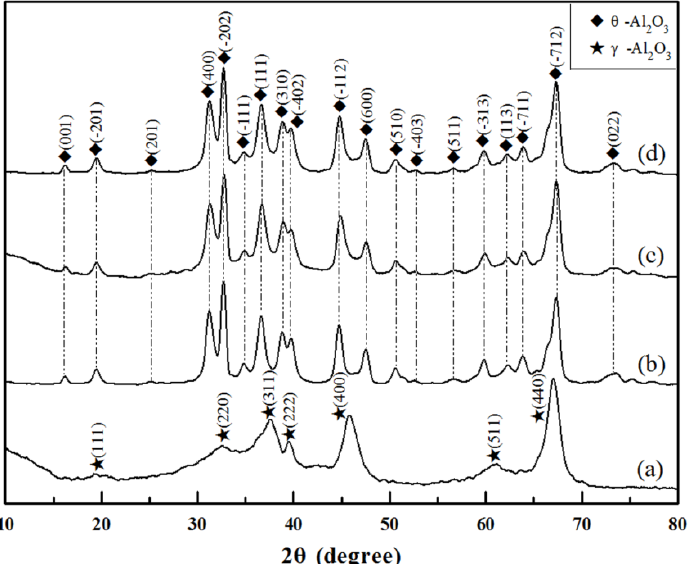
Figure 3. XRD spectra of annealed powders treated at 1000 °C for 6 h using the precursors prepared by the hydrothermal method with the different molar ratio of Al 3+ :CO(NH 2 ) 2 : ( a ) 1:3, ( b ) 1:5, ( c ) 1:6 and ( d ) 1:7. The referred diffraction peaks of γ-Al 2 O 3 are from ICSD 66559.